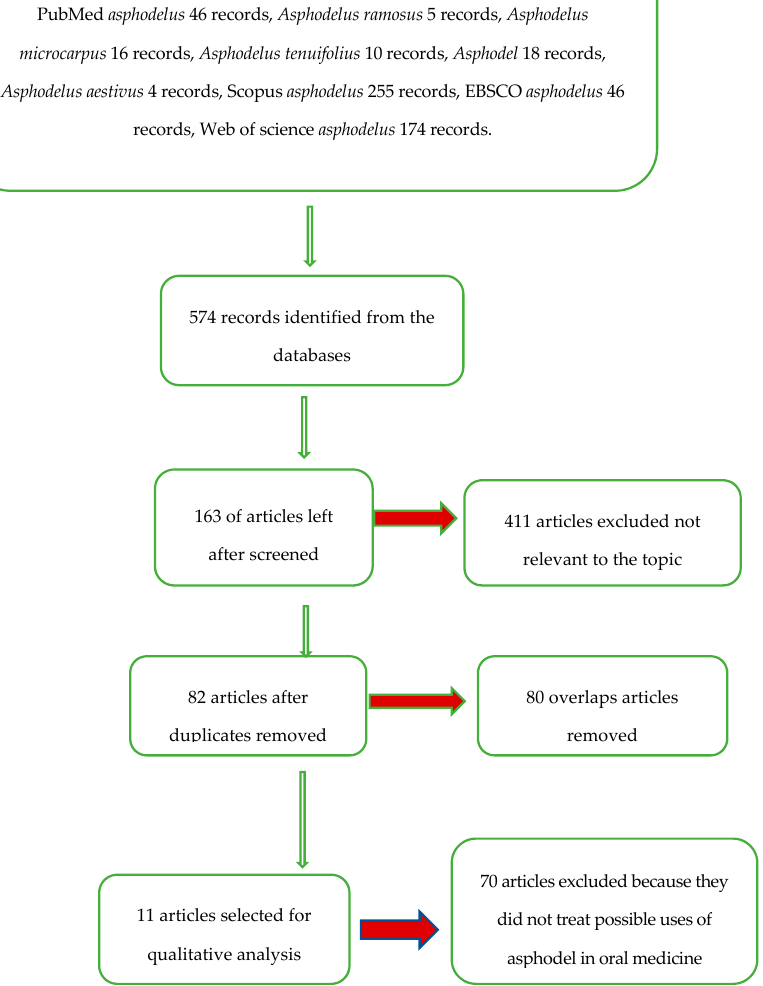
Figure 2. Flow chart of the different phases of the review.